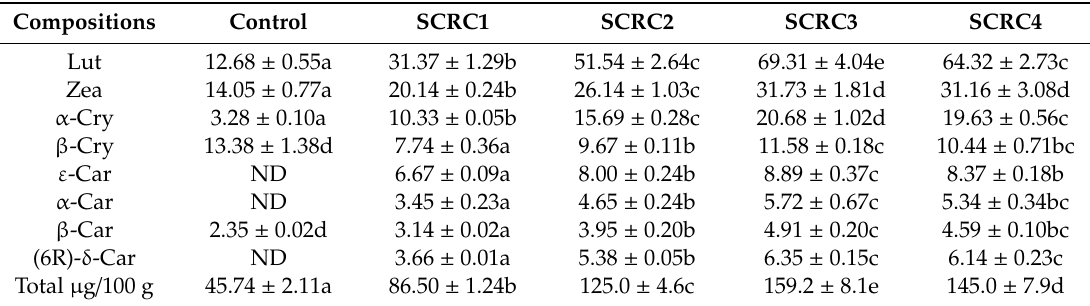
Table 6. Composition and content of carotenoids in